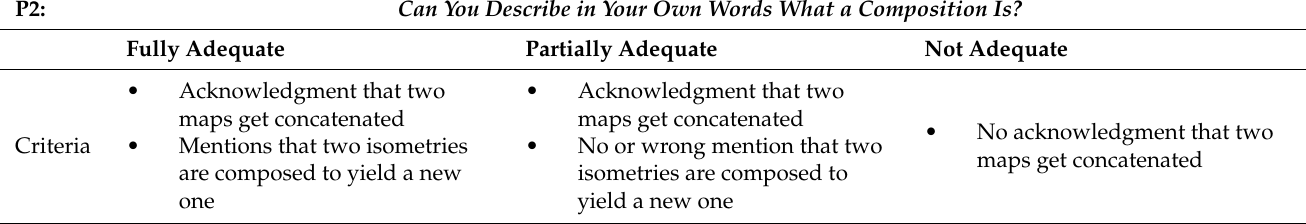
Table A10. Coding manual for the paraphrasing of key idea 2.